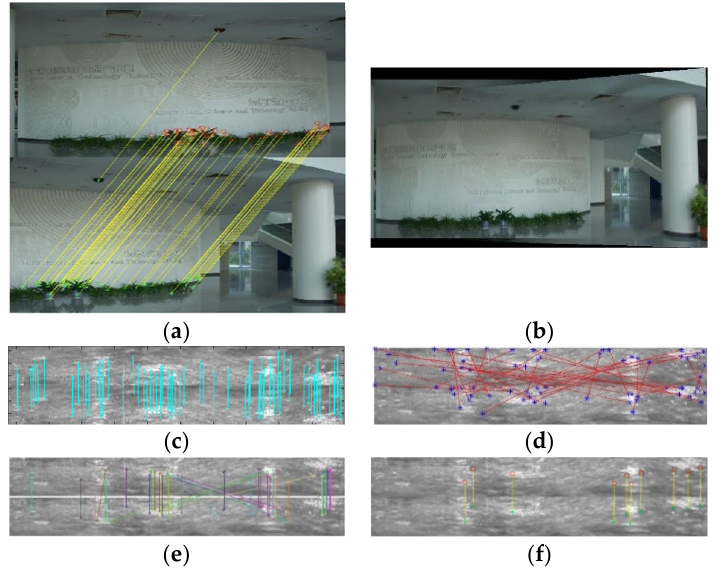
Figure 6. Matching effect of two images. ( a ) Nature image matching result; ( b ) nature image stitching result. ( c – f ) contain the borehole image matching results of SIFT, Harris, ORB and SURF algorithms, respectively.